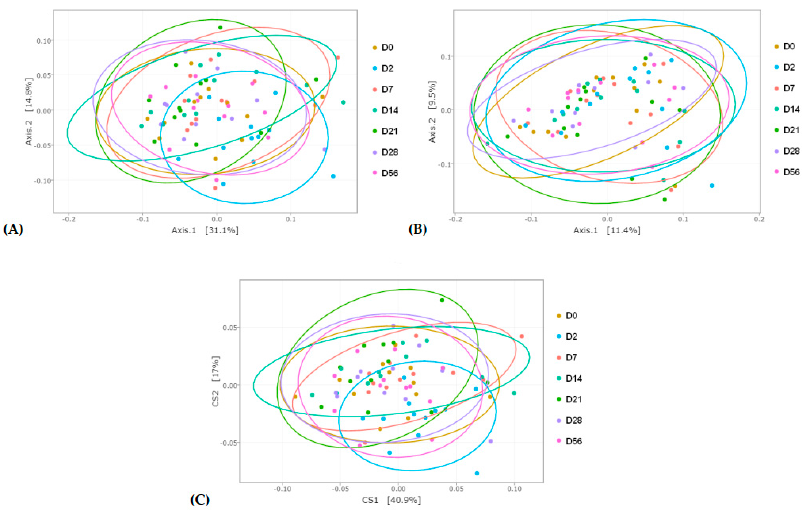
Figure 3. Principle coordinate analysis (PCoA) representing day (D)-related modifications of the bacterial membership and community structure in the feces of horses assessed by ( A ) weighted and ( B ) unweighted Unifrac distances. ( C ) Double PCoA (DPCoA) representing day-related modifications of the bacterial community structure and diversity assessed using abundance and phylogenetic components.